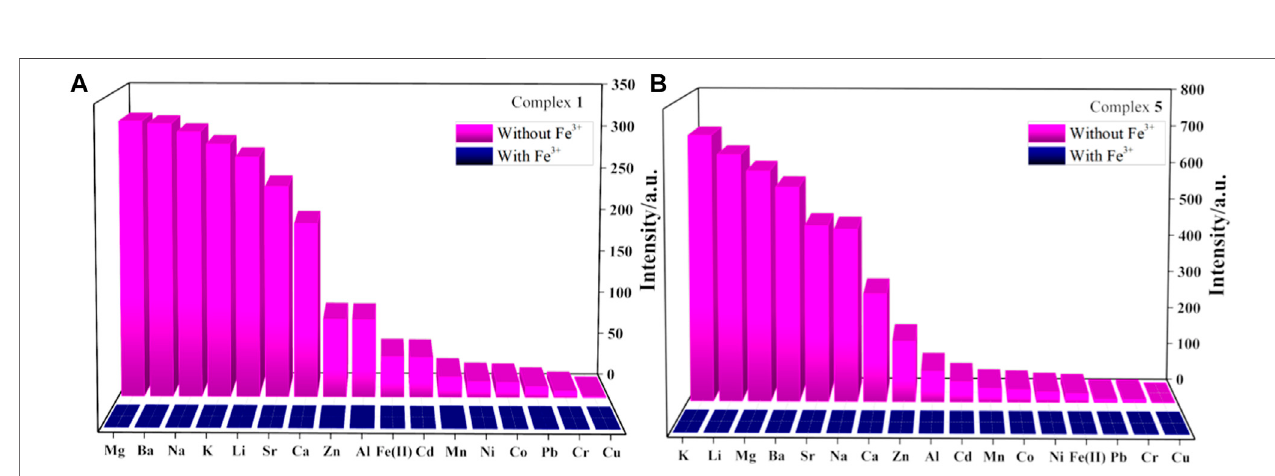
FIGURE 4 | (A,B) are fl uorescence intensity of complexes 1 and 5 dispersed in aqueous solutions of mixed cations without or with Fe 3+ , respectively.